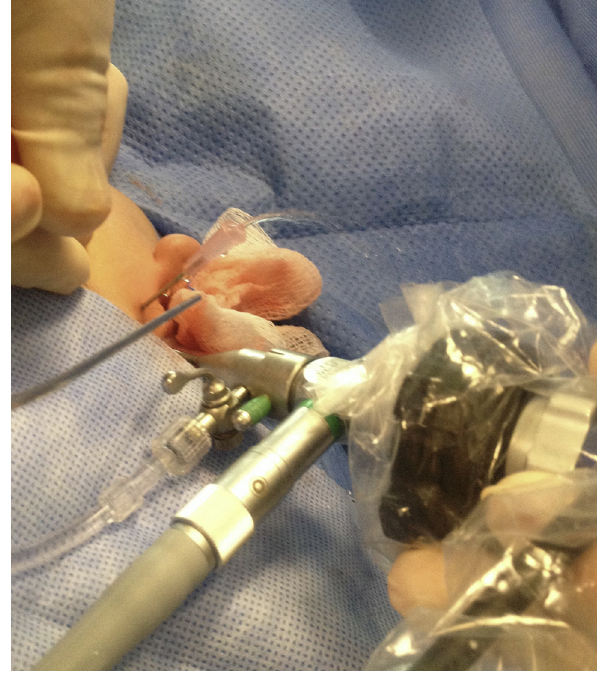
ALL being performed with the optical device in posi- tion, reflux needle and triangulation for instrumentation. therapy after this period. Physical therapy and plate use were maintained for 6 months postoperatively. All patients were evaluated postoperatively at 24 h, 72 h, 7 days, 15 days, 21 days and 30 days, and then monthly. During follow- up, pain improvement in function (VAS and load testing) and improved mouth opening amplitude were evaluated. All complications arising from ALL were also evaluated, with the exception of: pain at the puncture site; discrete pos- terior open bite, and transient limitation of mouth opening (such events are expected in the early days, being inherent